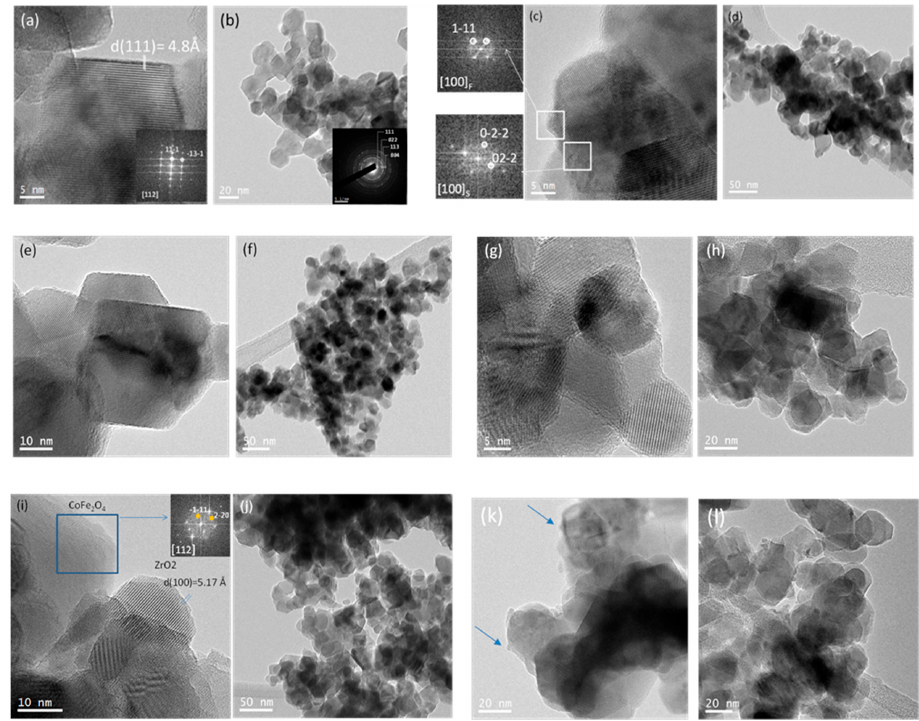
Figure 2. ( a ) HRTEM (high resolution transmission electron microscopy) of a particle of CoFe 2 O 4 oriented down the [112] zone axis of the spinel structure. ( b ) Representative low magnification TEM micrograph of the CoFe 2 O 4 and its corresponding SAED pattern. ( c ) HRTEM of the 1Ce/CoFe sample and the FFT of both phases (fluorite and spinel) oriented along the [100] zone axis in both structures. ( d ) TEM micrograph of the 1Ce/CoFe sample. ( e ) HRTEM of the 1Co/CoFe sample. ( f ) Low magnification TEM image of 1Co/CoFe. ( g ) HRTEM of the 1Cu/CoFe sample. ( h ) Low magnification TEM image of 1Cu/CoFe. ( i ) HRTEM of the 1Zr/CoFe sample. The FFT shows a spinel CoFe 2 O 4 particle in the [112] zone axis. ( j ) Low magnification TEM image of 1Zr/CoFe. ( k , l ) TEM micrographs of the 10Ce/CoFe sample. Blue arrows mark dispersed CeO 2 particles.